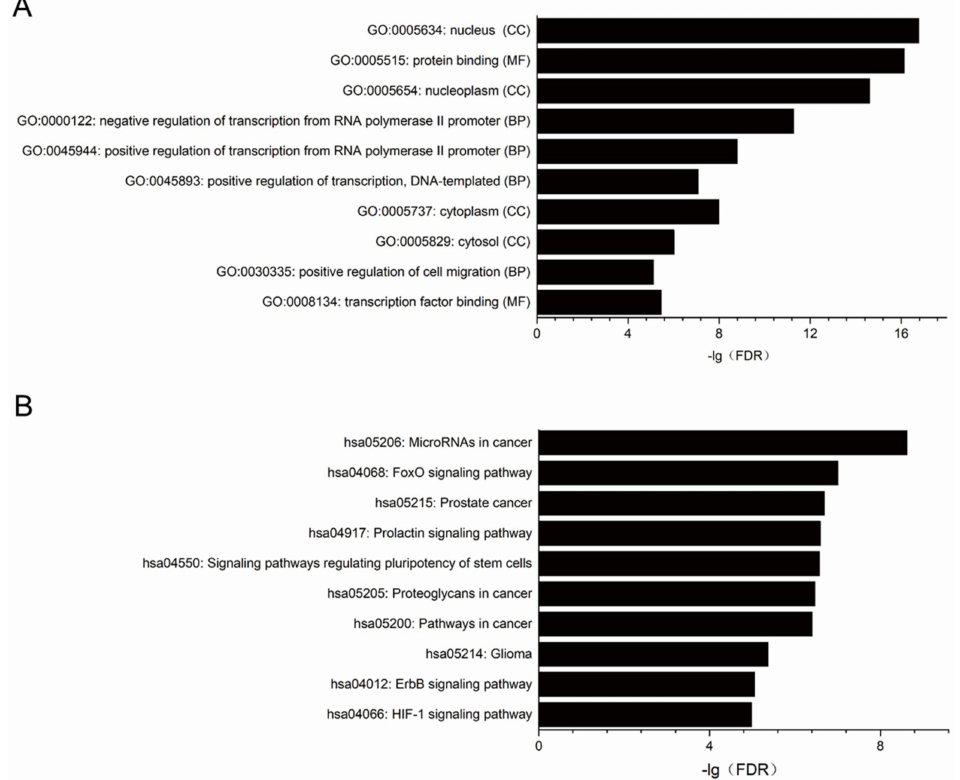
Figure 2. Enrichment analysis of GO function and pathways for predicted miRNAs targets significantly di ff erent expressed in PDAC cell lines. ( A ) GO function enrichment analysis. ( B ) KEGG pathway enrichment analysis. Only the top ten GO terms and pathways were shown in this figure. FDR < 0.05 was set as criteria for